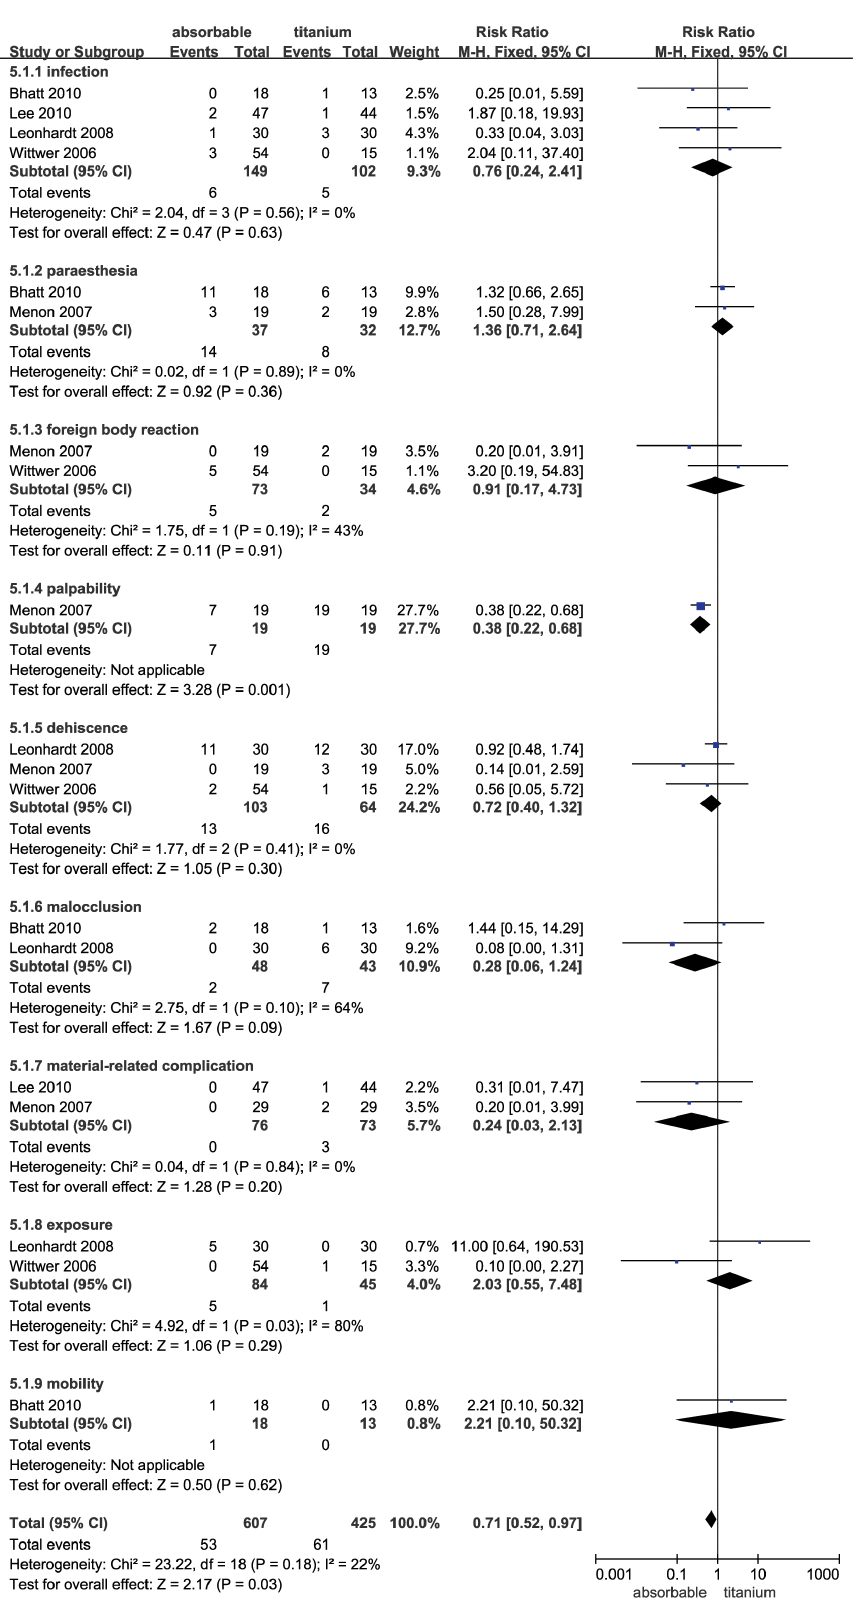
Figure 7. Forest plot of trials of absorbable fixation versus titanium examining the effect on relative risk of complications in fracture fixation. See Figure 2 legend for expansion of abbreviations.